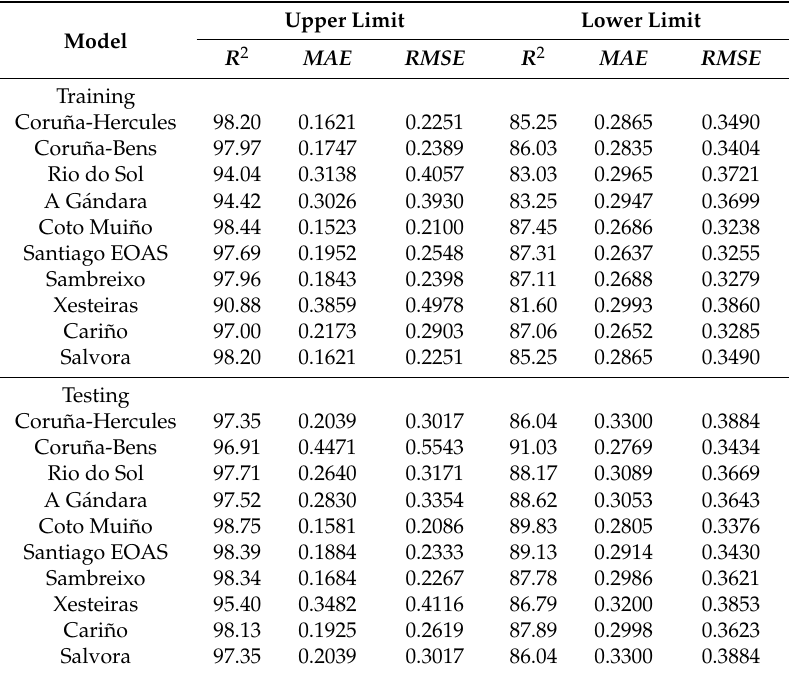
Table 9. Results of the training and testing of the MLR models of approach 2.